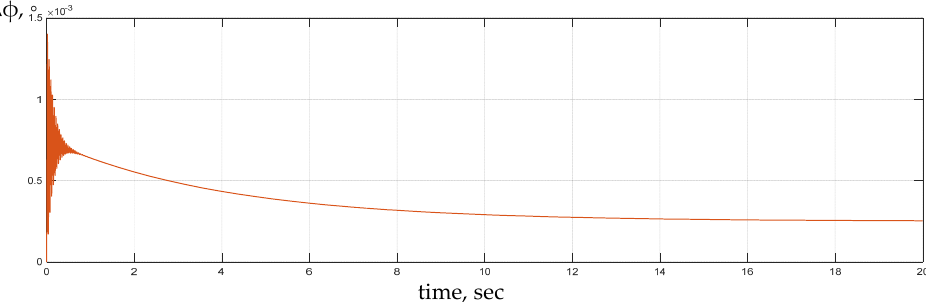
Figure 4. Dependence of the twist angle change Δϕ during acceleration for γ = 0.5.